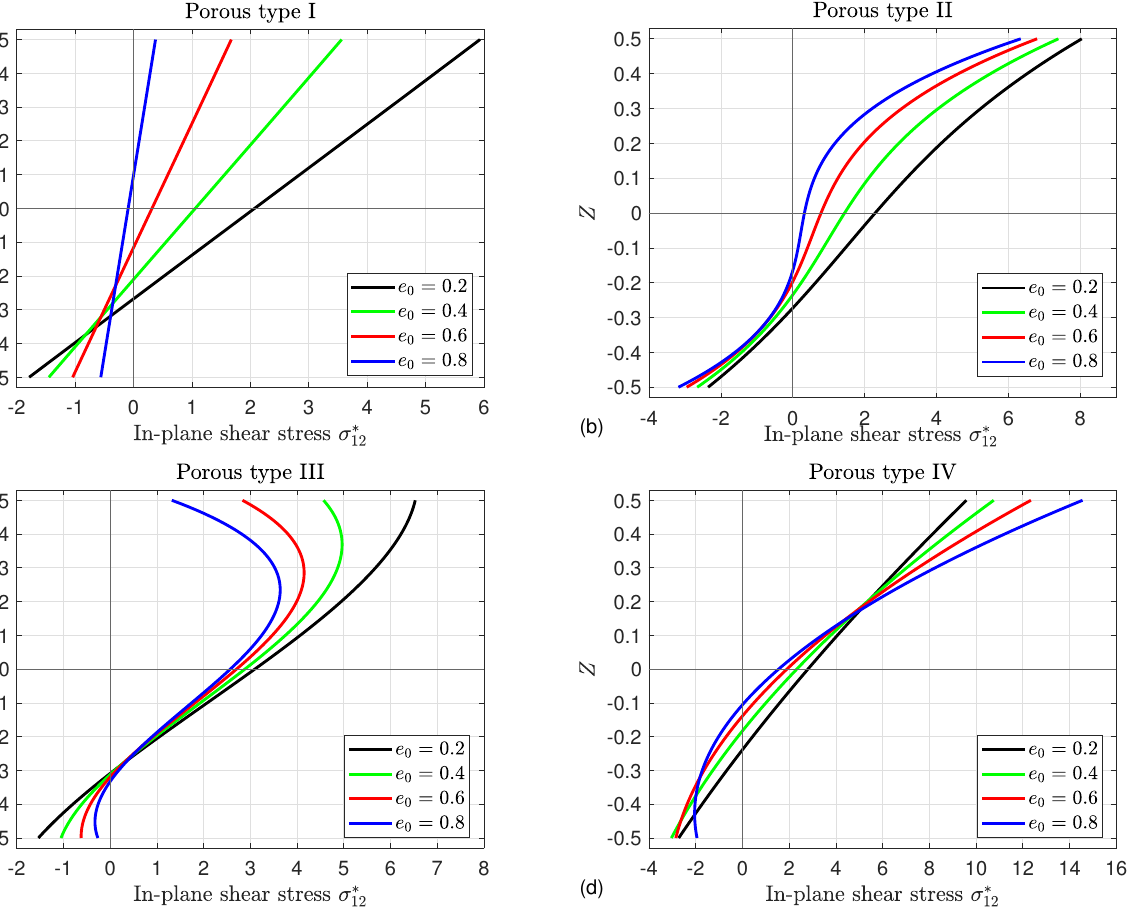
Figure 6. Influence of the porosity factor e 0 on the transverse shear stress σ ∗ posite piezoelectric square plates for different porosity distribution types: ( a ) Type I, ( b ) Type II, ( c ) Type III and ( d ) Type IV.